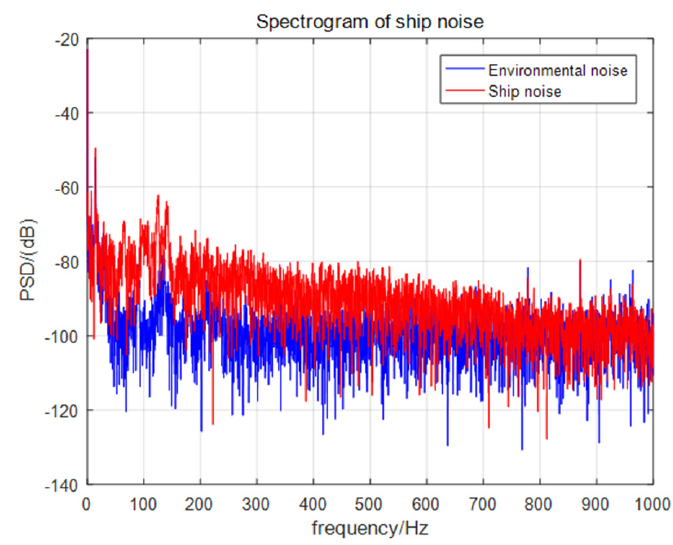
Figure 17. Experimental field of ship noise acquisition.